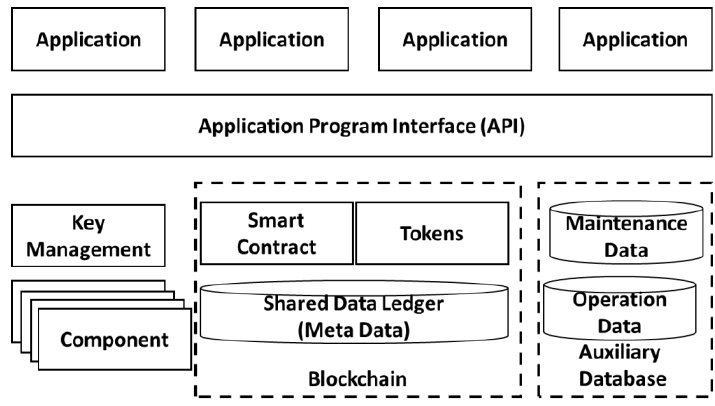
Figure 2. Blockchain in the software architecture.